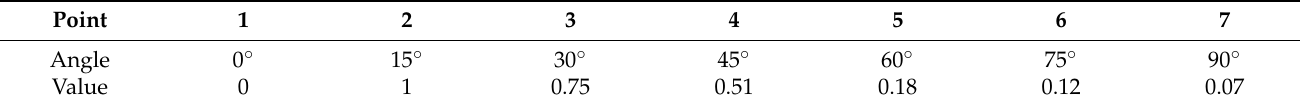
Table 1. Parameters of the impact angle